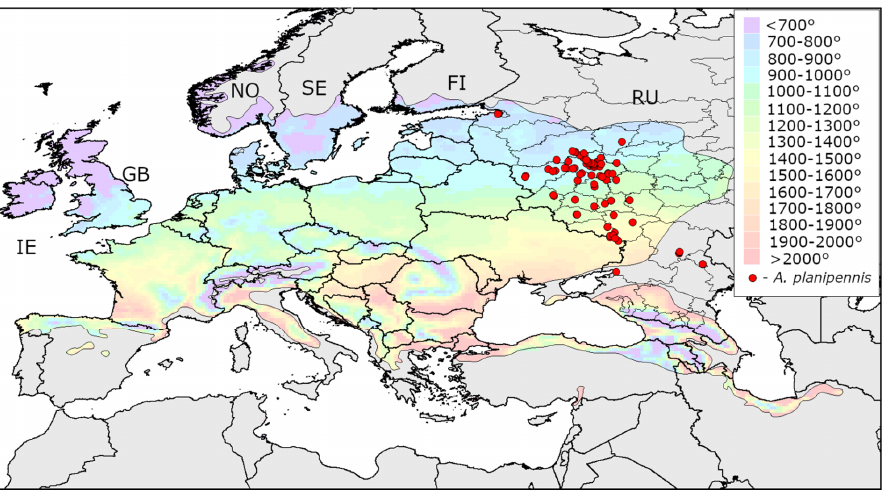
Figure 6. Heat availability in the native range of Fraxinus excelsior in Europe. Mean AGDD 10 per year in 2003–2020 within the native range of F. excelsior is indicated with colours (see the legend). FI—Finland, GB—Great Britain, IE—Ireland, NO—Norway, RU—Russia, 3.2.2. The Distribution of Heat Availability within the Range of Fraxinus Excelsior in Scandinavia The only native ash species in the northern part of Europe is European ash ( F. e xcel- sior ) [26]. Heat availability is below 700° AGDD 10 in the most part of Norway, Sweden, and Finland (Figure 7). There is a hope that these regions could potentially become the refuges for F. excelsior, where ash trees could escape from A. planipennis . In Denmark, Es- tonia, southern regions of Sweden and regions along the southern coasts of Norway and Finland, AGDD 10 is from 700 to 800 °C, i.e., about the minimum recorded in the territories occupied by A. planipennis .